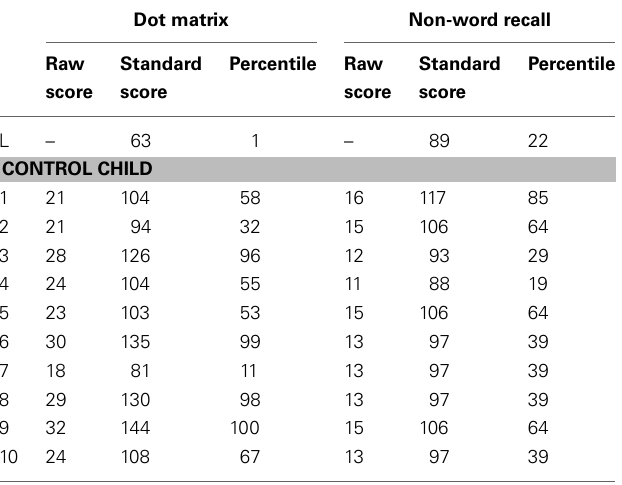
The standard scores have a mean of 100 and a standard deviation of 15.